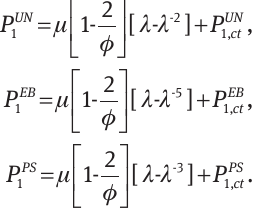
The parameter μ represents the shear modulus, φ counts the number of chains joining at a junction, and κ measures the strengths of the constraints. The P ( λ ) relations for the three defor- i i mation modes are obtained from Eq. (23) as